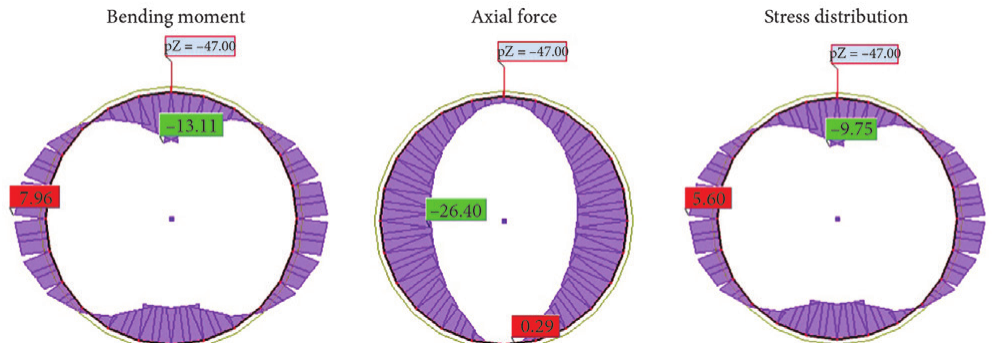
Fig. 5. The internal forces and stress values in the analysed pipe for the load F = 47